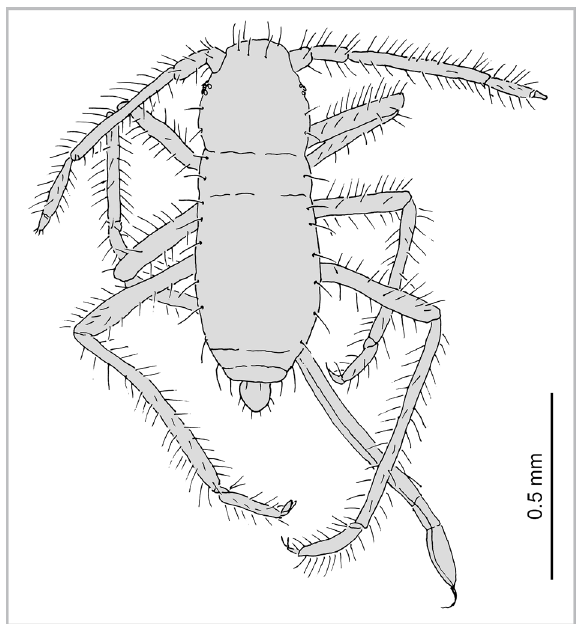
Fig. 40. Prociphilus (Prociphilus) bumeliae (Schrank, 1801). Young aptera from Abies root (after Heie 2004,